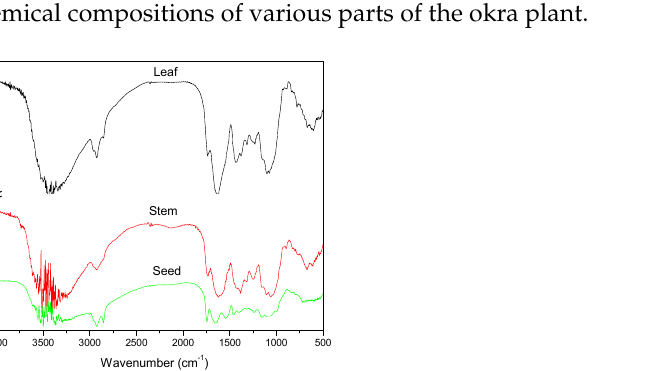
Figure 6. SEM images and EDX spectra of silver nanoparticles, S0 and S20.